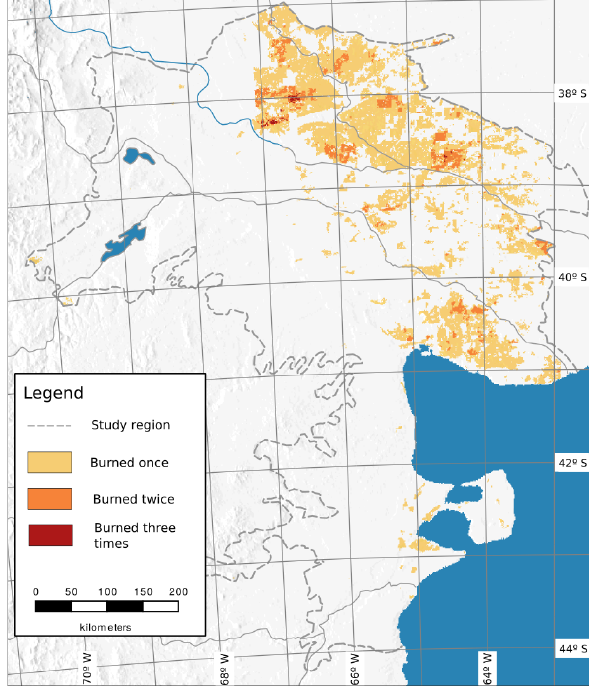
Figure 3: Burned areas mapped by the burned area algorithm over the 2001–20011 period.